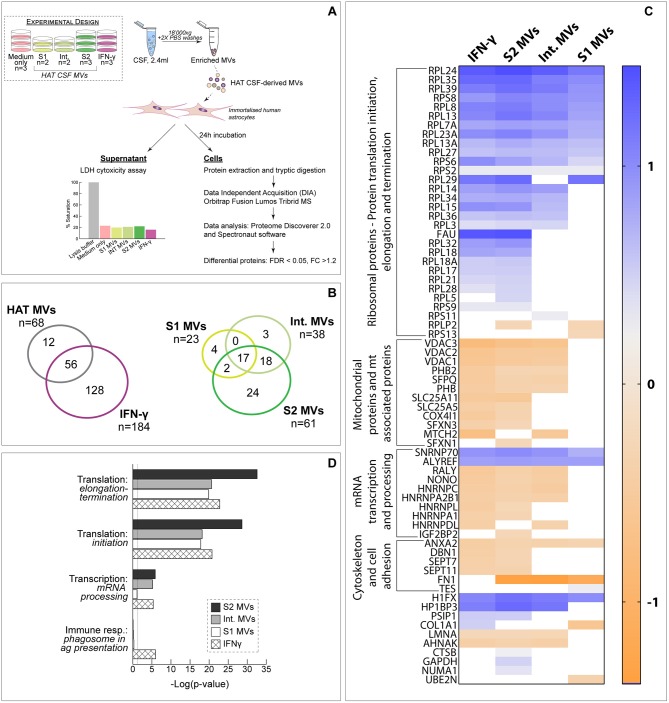
Exposure of human astrocytes to HAT CSF MVs. (A) Schematic representation of the experimental design. The results of the LDH assay, showing the absence of toxicity on astrocytes upon 24 h exposure to MVs, is also reported. (B) Comparison of the proteins identified in the different analyzed samples. (C) Heat-map comparing the protein fold change (FC) between the different study conditions and untreated control cells. Only proteins significantly differentially expressed (FDR < 0.05 and |FC| >1.2) upon exposure to at least one type of HAT MVs (i.e., S1, Int. or S2) are represented. (D) Process networks significantly represented amongst differentially abundant proteins.